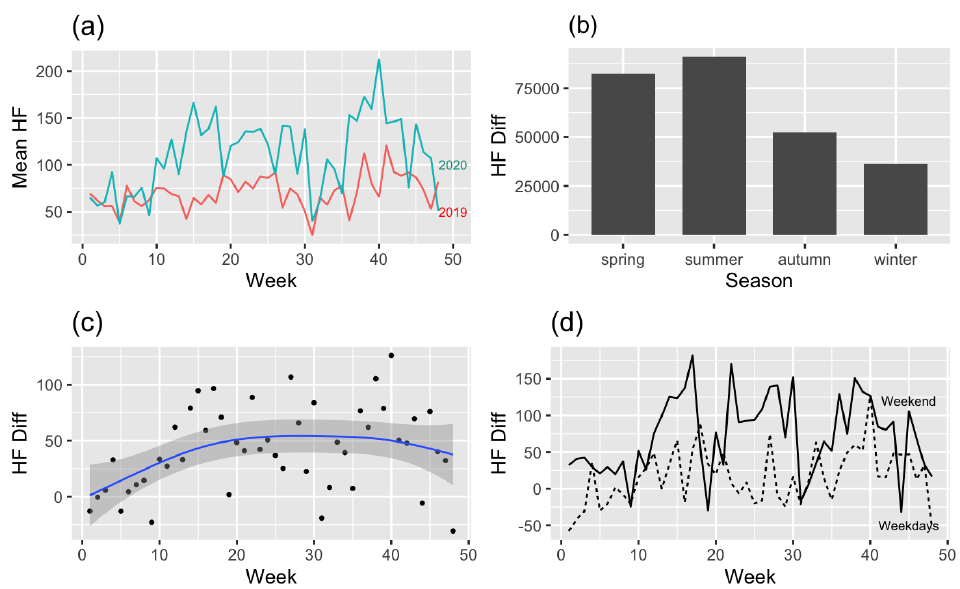
Figure 3. ( a ) Mean hiking frequency (2019–2020) by week, ( b ) Hiking difference count by season, ( c ) regression model (linear mixed model) graph of hiking frequency difference (2019–2020), and ( d ) difference of hiking frequency between weekdays and weekends